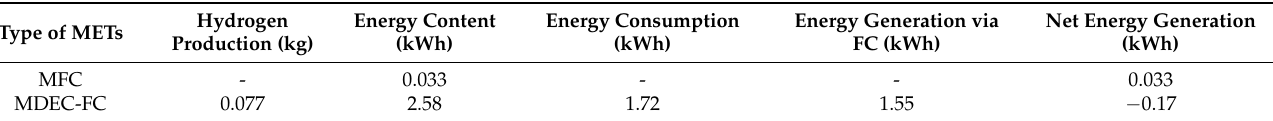
Table 2. Energy generation via MFC and MDEC-FC by treating 1 m 3 of domestic wastewater.